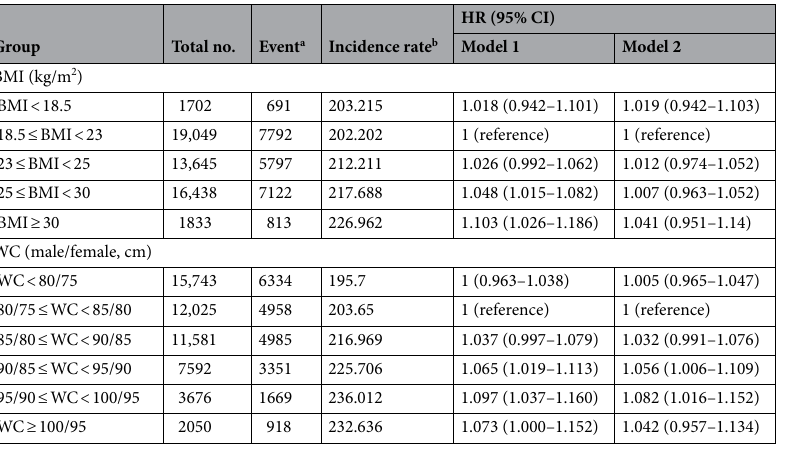
Table 1. Multivariable Cox proportional hazards models to determine the HR for longer duration CSU according to WC and BMI. BMI body mass index, CI confidence interval, CSU chronic spontaneous urticarial, HR hazard ratio, WC waist circumference. a Event; disease duration over 3 years, b per 1000 person-years. Data were expressed as HR and 95% CI. Model 1 was adjusted for age and gender. Model 2 was adjusted for age, gender, comorbidities of diabetes mellitus, hypertension, and